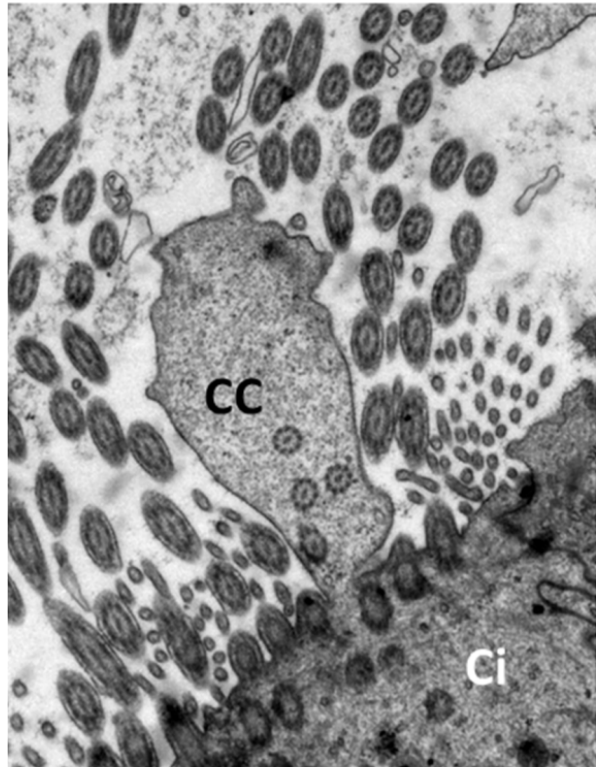
Figure 7. Transmission electron micrograph of a ciliated cell (Ci) originating from the tracheal respiratory epithelium of a new- born marmoset ( Callithrix jacchus ). In the airway lumen numerous cross-sectioned cilia present normal axonemes consisting of a cen- tral pair of filaments surrounded by nine other pairs. In addition to normal cilia an atypical cilium (CC) is demonstrated. This malfor- mation belongs to compound cilia of bulging type which contains loosely and randomly embedded